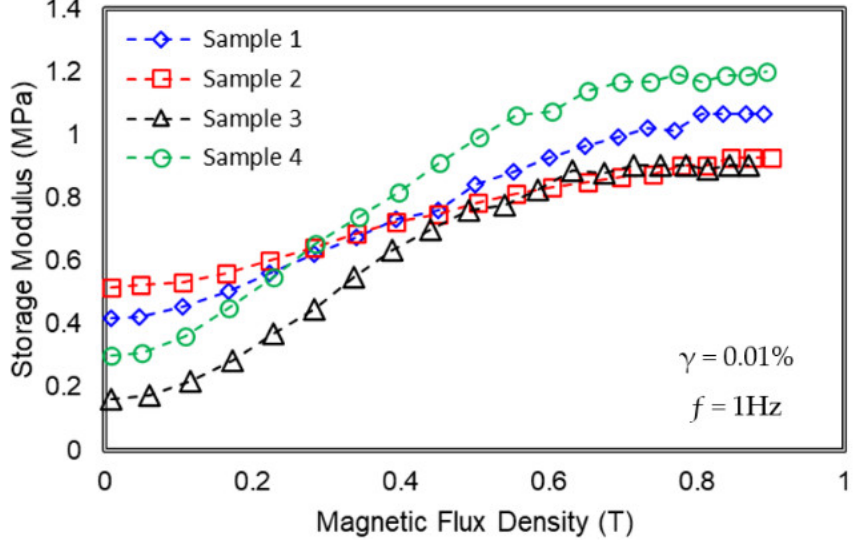
Figure 2. Storage modulus MRE samples at various magnetic flux densities.